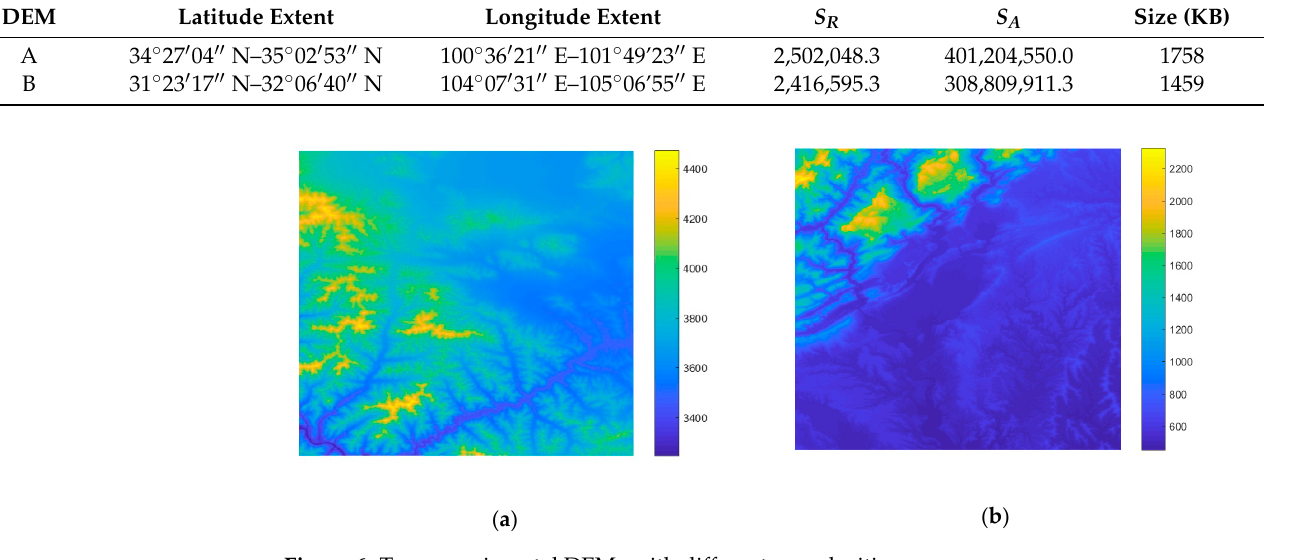
Figure 6. Two experimental DEMs with different complexities.